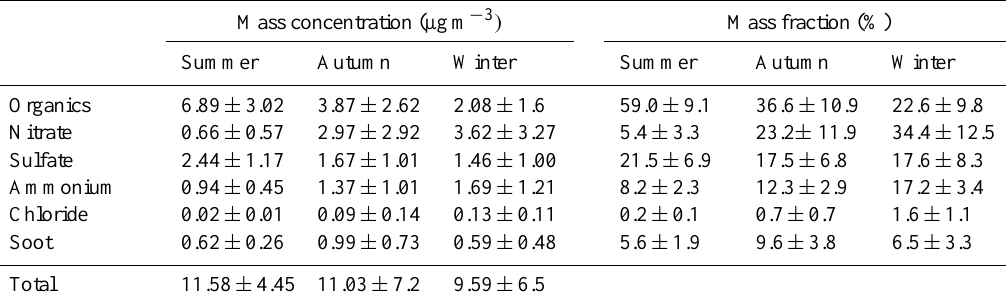
Table 2. Summary of the particle mass composition for the three measurement periods. The reported mass concentrations correspond to the mean value and the errors to the standard deviation calculated over each entire measurement period.